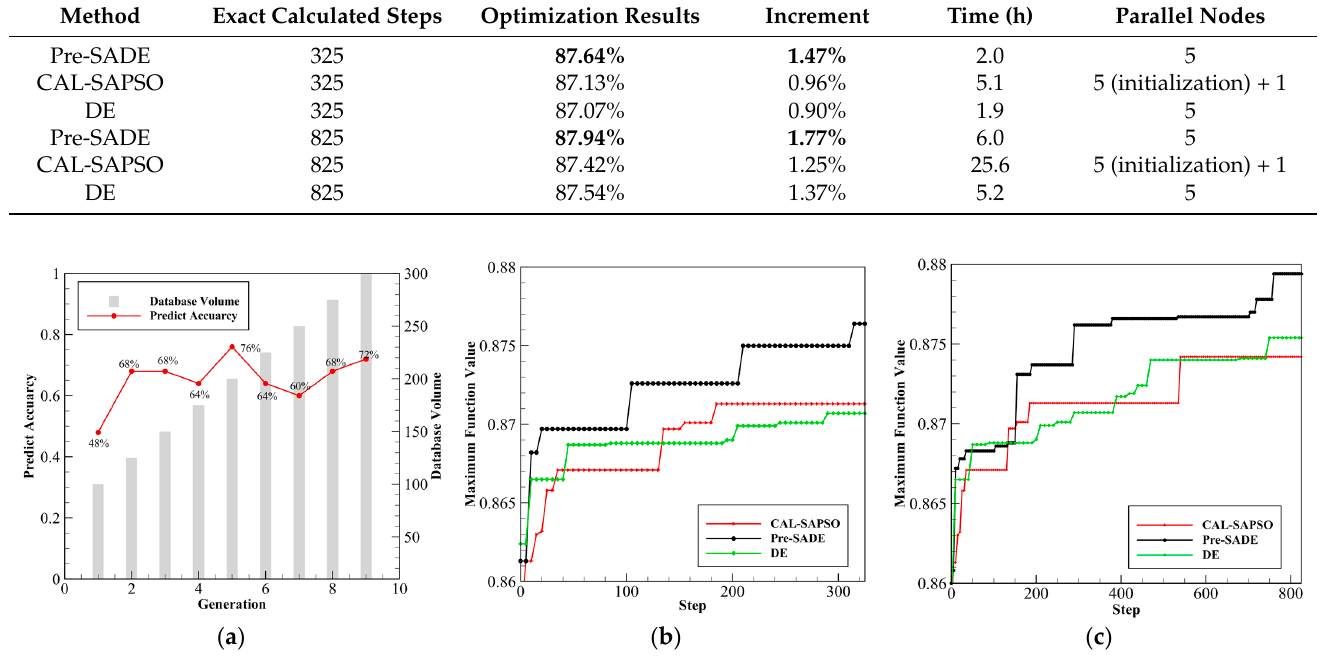
Table 3. The optimization results of pre-SADE, CAL-SAPSO, and DE.